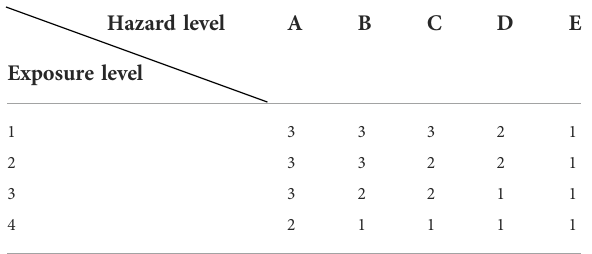
TABLE 2 The risk matrix of Stoffenmanager Nano